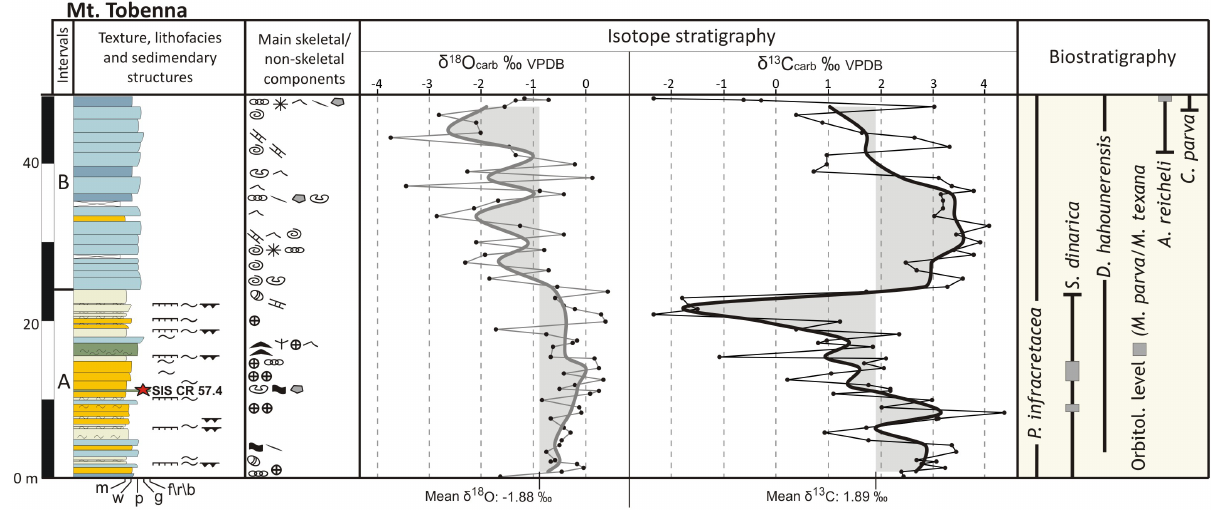
Fig. 10. Mt. Tobenna section: lithological–sedimentological log, isotope stratigraphy and biostratigraphy. The thick curves represent the 3-point moving averages of O- (grey) and C-isotope ratios (black). See Fig. 8 for a key to colours, patterns and